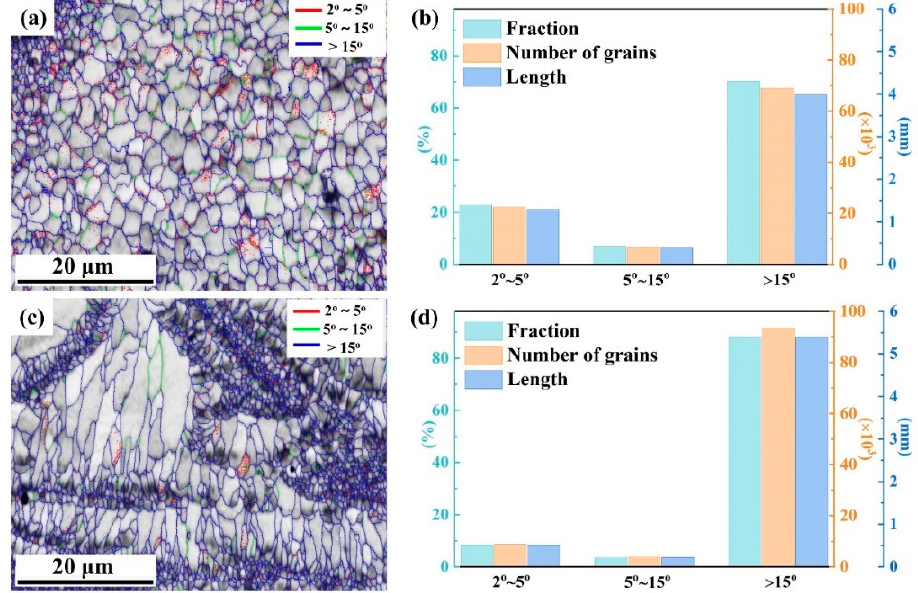
Figure 6. Grain boundary maps of the as-built sample: ( a ) XY plane; ( b ) quantitative results of ( a ); ( c ) XZ plane; ( d ) quantitative results of ( c ).